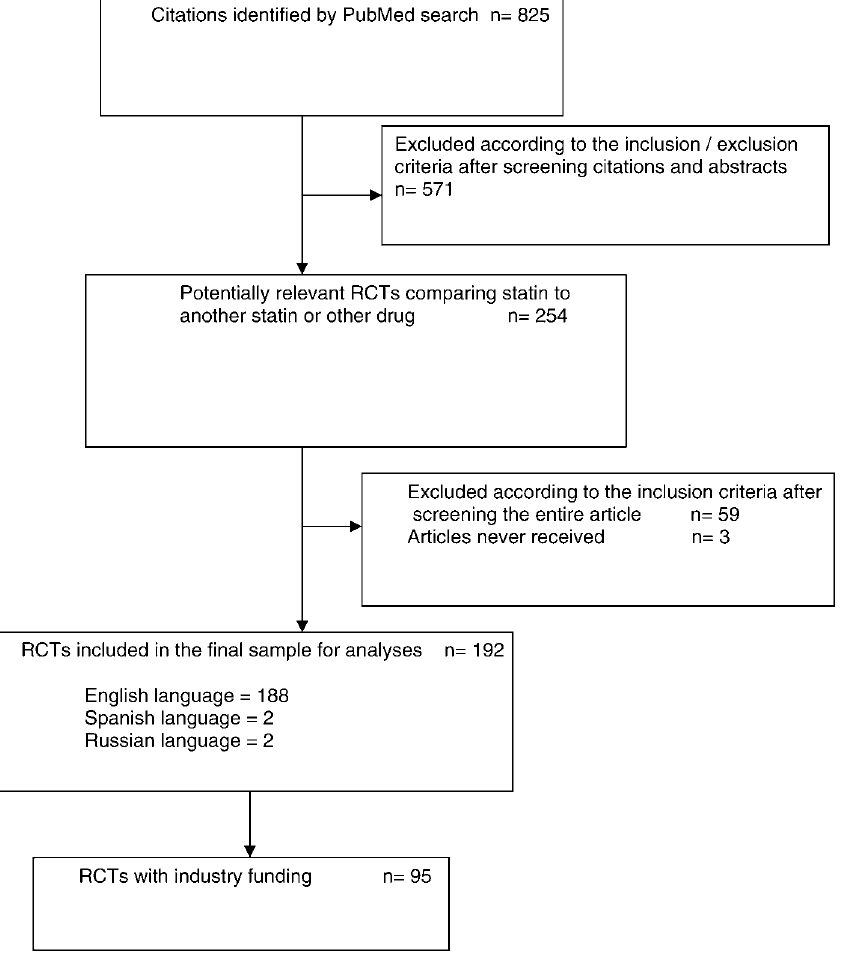
Figure 1. Flowchart of Manuscript